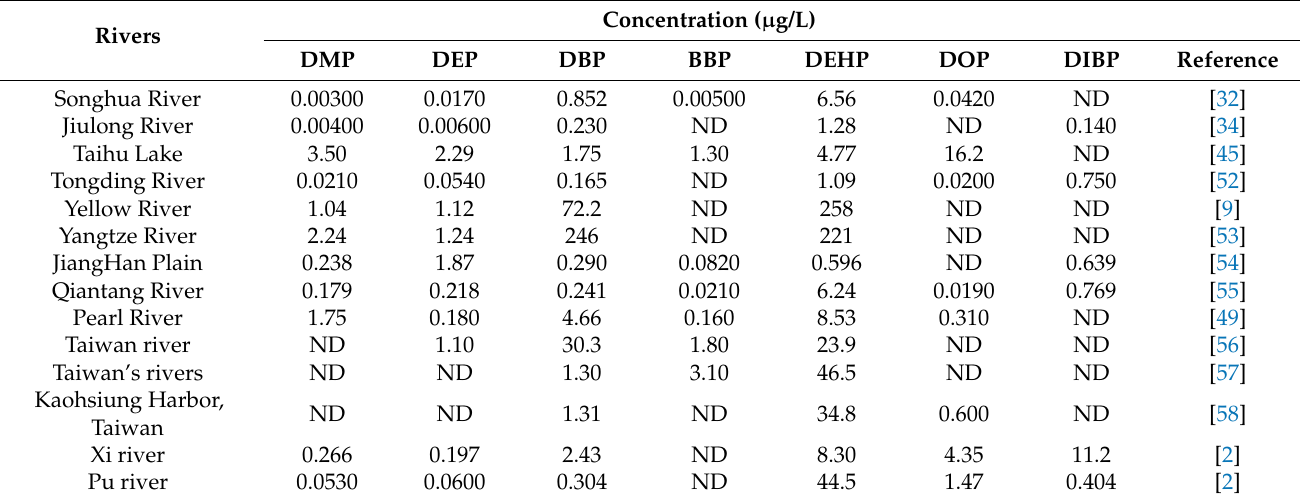
Table 3. Part of PAEs in sediments from typical rivers in China ( µ